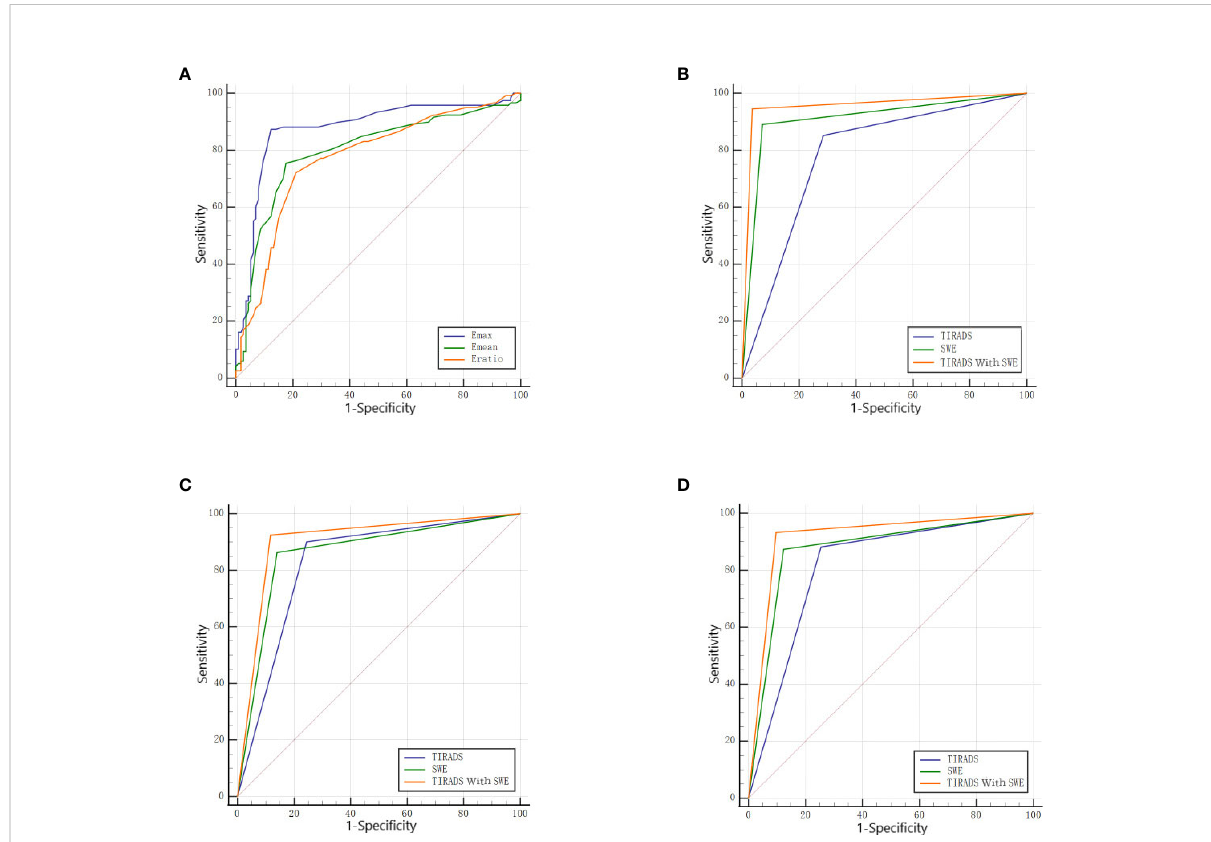
FIGURE 4 (A) The ROC of each parameter in SWE. (B) The ROC of the TIRADS alone, SWE alone, and the combination of the two in the D ≤ 10mm group. (C) The ROC of the TIRADS alone, SWE alone, and the combination of the two in the D>10mm group. (D) The ROC of the TIRADS alone, SWE alone, and the combination of the two in all